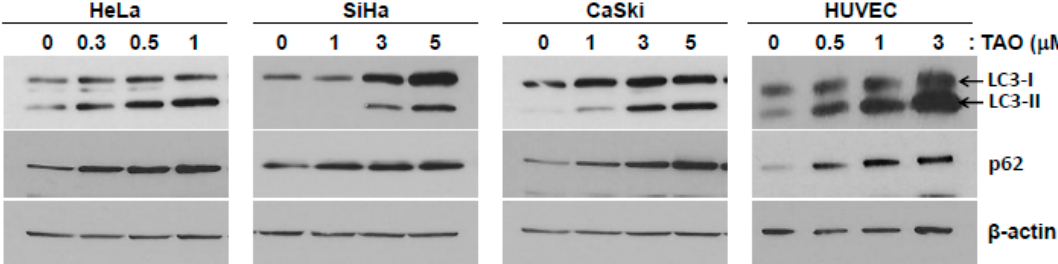
Figure 4. Western blot analysis of autophagy-related proteins in cervical cancer cell lines and HUVECs. The conversion of LC3-II increases as the concentration of TAO increases. Increasing concentrations of p62 are seen as concentrations of TAO increase, suggesting the inhibitory effects of TAO on autophagy.